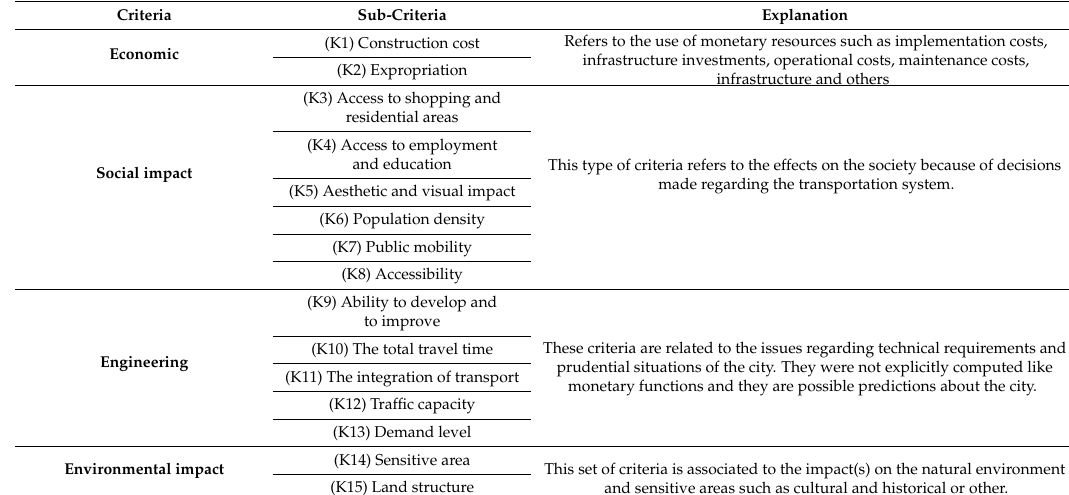
Figure 3. Strategic decision framework. Table 2. Criteria for the route selection.